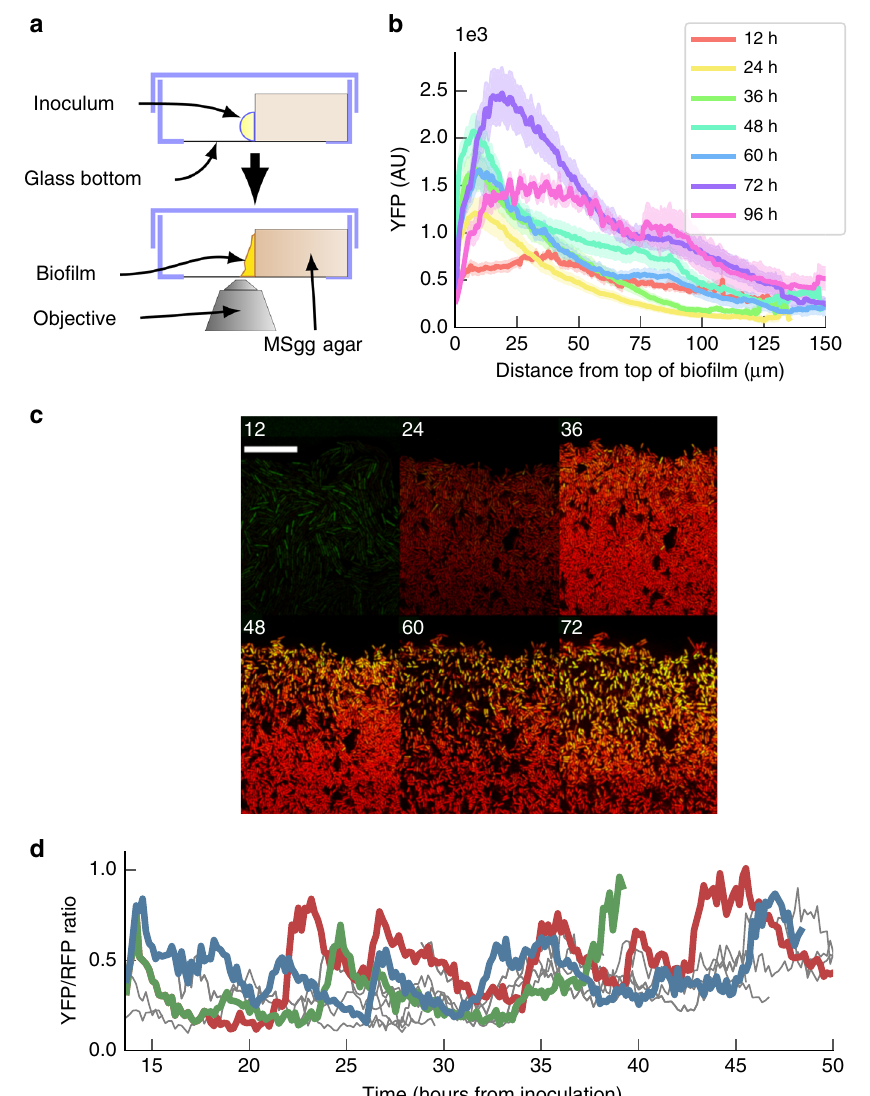
Fig. 4 σ B pulses in individual cells during bio fi lm development. a Experimental setup used to capture time-lapse confocal images of the growing bio fi lm. A glass bottom dish is partially fi lled with MSgg agar. Cells are inoculated on the agar surface in contact with the glass. The bio fi lm grows on the agar surface, allowing time-lapse microscopy across a cross-section of the bio fi lm. b Quanti fi cation of σ B gradient from live bio fi lm snapshots taken every 12 h, error bars indicate the SEM. n = 17 from two experiments. c Snapshots of the top of the live bio fi lms taken at 12 h intervals after inoculation shows development of a σ B gradient of expression. Snapshots are merged P μ m. d Ratiometric expression of P sigA -RFP (red) and P sigB -YFP (green) channels. Scale bar is 20 sigB -YFP/ P sigA – RFP in a selection of cells tracked for over 40 h shows sustained pulsing of P sigB- YFP during bio fi lm growth. Source data are provided as a Source Data fi